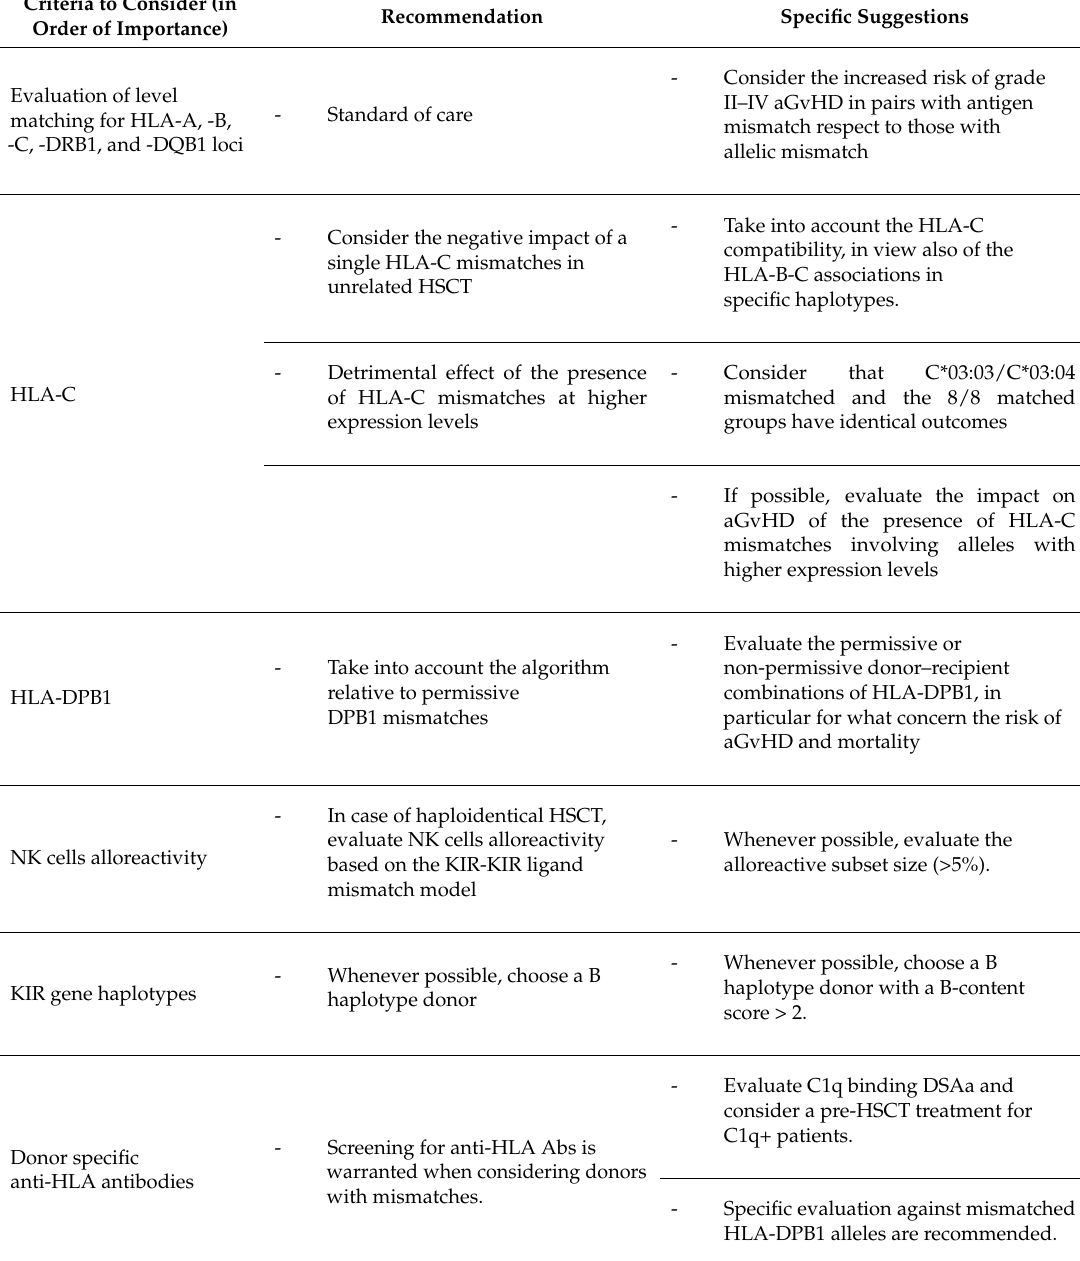
Table 1. Suggested criteria to consider for selecting the best hematopoietic stem cell transplantation donor. Criteria to Consider (in Order of Importance)